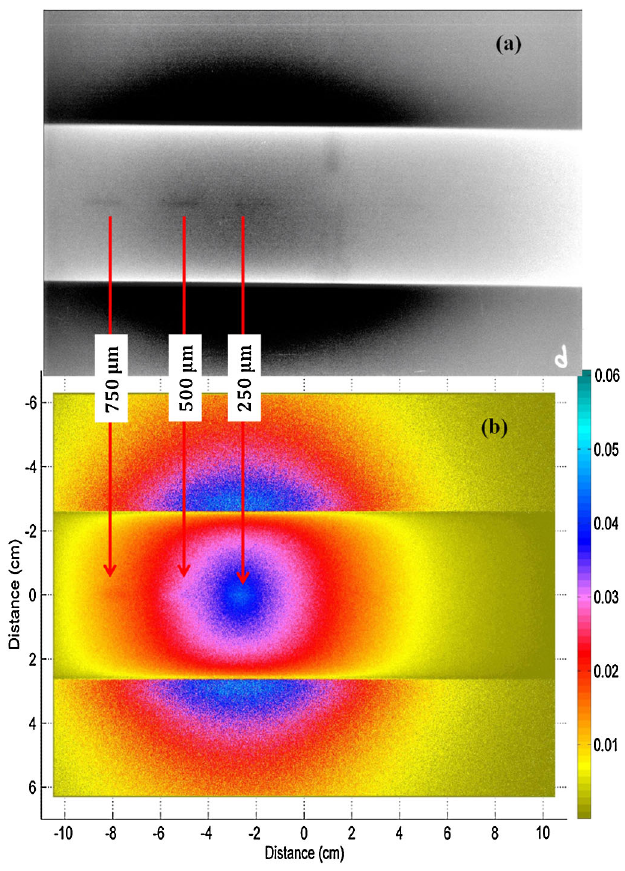
FIG. 4. (a) Processed experimental radiograph indicating the embedded gaps of width 750, 500, and 250 (cid:2) m . (b) Monte Carlo simulated radiograph shows reasonable agreement with the experimentally obtained image where the 750, 500, and 250 (cid:2) m voids are visible at (cid:1) 8 , (cid:1) 5 , and (cid:1) 2 : 5 cm , respectively. The intensity numbers on the color bar code indicate the energy deposited by the electrons on the image plate, in MeV per source electron in each voxel. The voxel volume considered in the MC simulation is 200 (cid:2) m (cid:3) 200 (cid:2) m (cid:3) 115 (cid:2) m